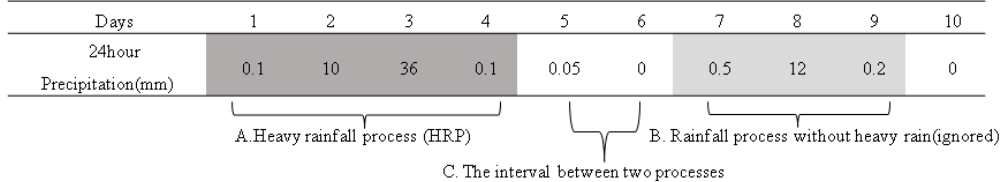
Figure 1. Illustration of defining a heavy rain process (HRP).